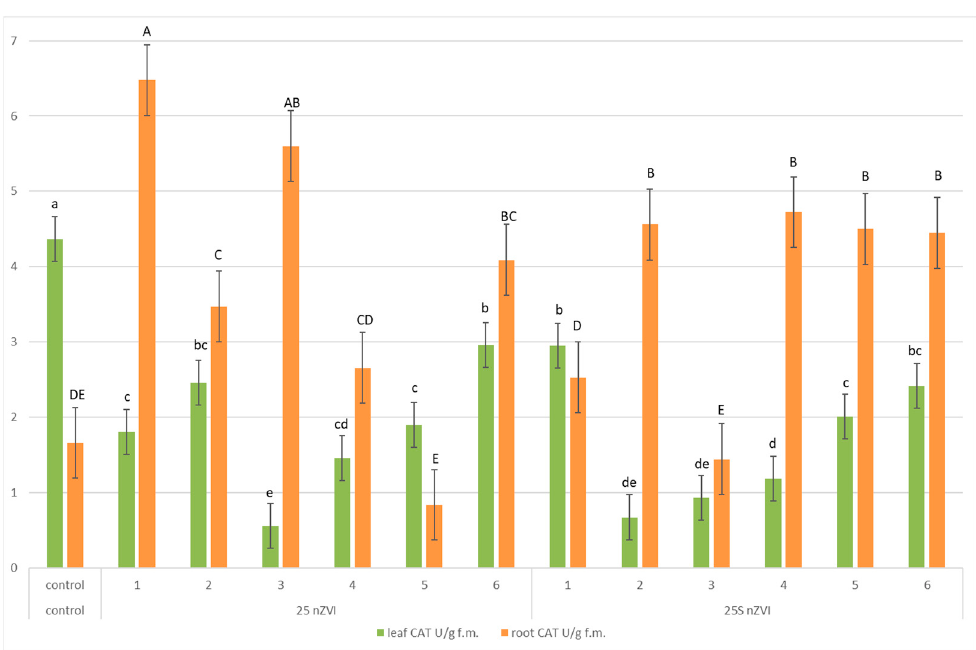
Figure 7. The content of enzymes: Pyrogallol peroxidase (POD) in shoots ( i ), POD in roots ( ii ), superoxide dismutase (SOD) in shoots ( iii ) and SOD in roots ( iv ) of plants grown in soil contami- nated with 25 and 25S nZVI. The numbers 1–6 correspond to the following concentrations: 0.5; 1; 5; 10; 50 and 100 g nZVI/kg soil. Vertical bars represents the mean values (n = 5) ± standard devia- tions. Different letters indicate significant difference at p < 0.05 by LSD test.